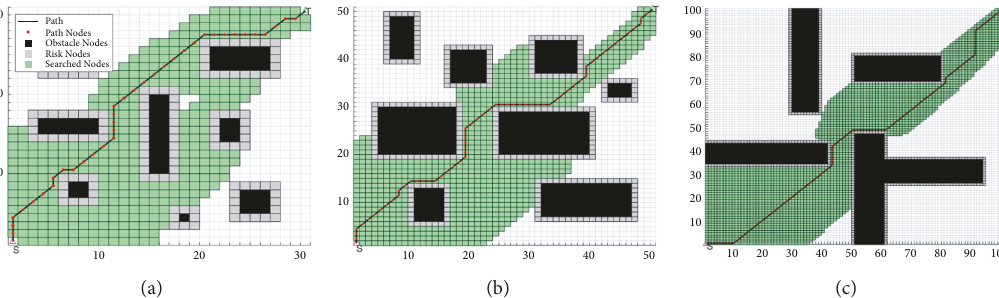
Figure 13: This paper grid method environment modeling+traditional A ∗ (security A ∗ ). (a) 30 ∗ 30. (b) 50 ∗ 50. (c) 100 ∗ 100.